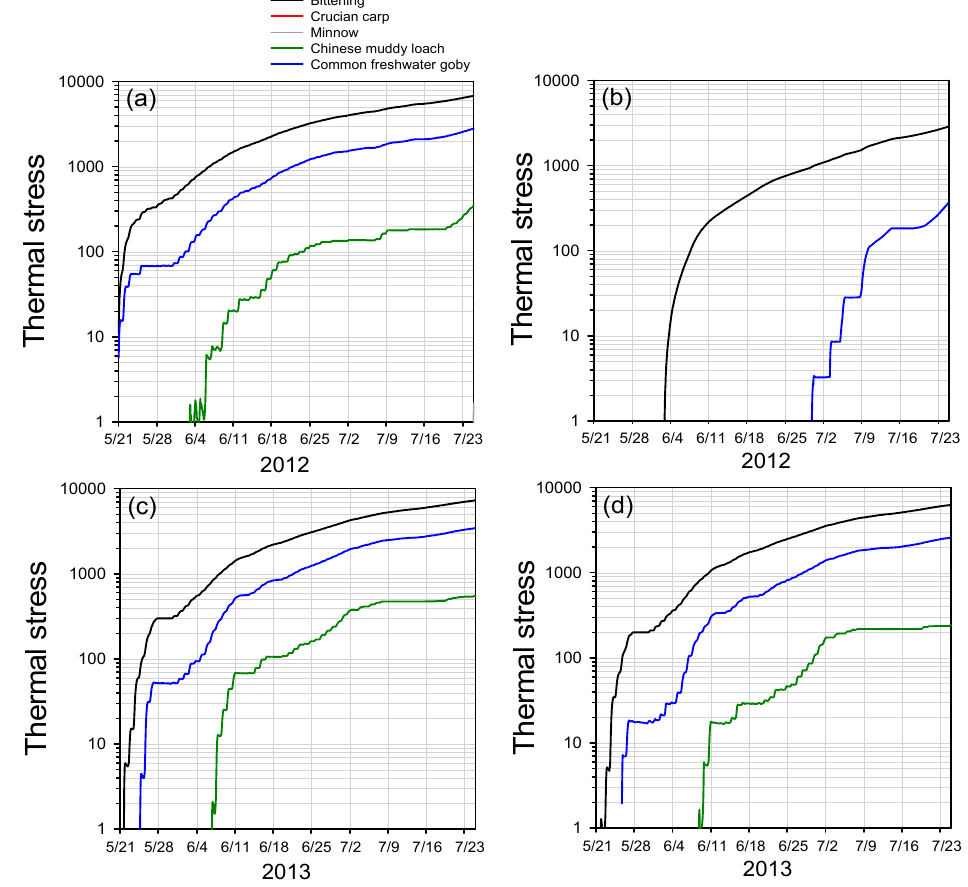
Figure 5. Thermal stress results for fish fauna in study site. ( a ) Open space (St. 1) for stagnant conditions in 2012. ( b ) Inside the ADP (St. 2) for stagnant conditions in 2012. ( c ) Open space (St. 1) for circulation conditions in 2013. ( d ) Inside the ADP (St. 2) for circulation conditions in 2013. Crucian carp and minnow showed ND.